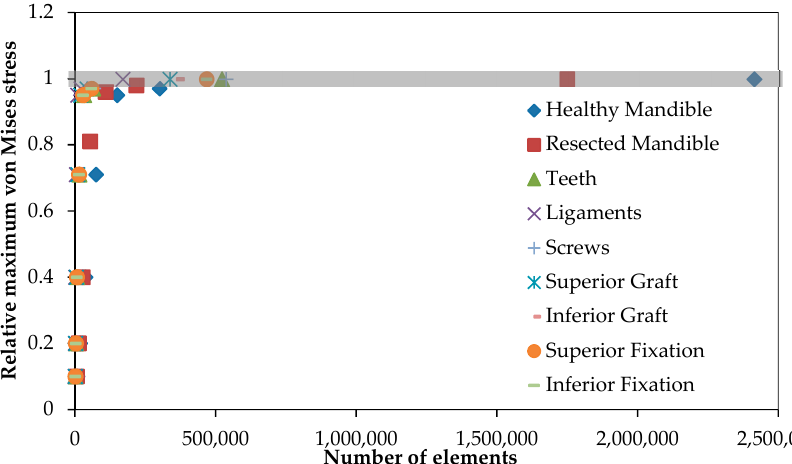
Table 1. The number of elements for the Finite Element Analysis model components. The number of tetrahedral elements was determined by convergence analysis.